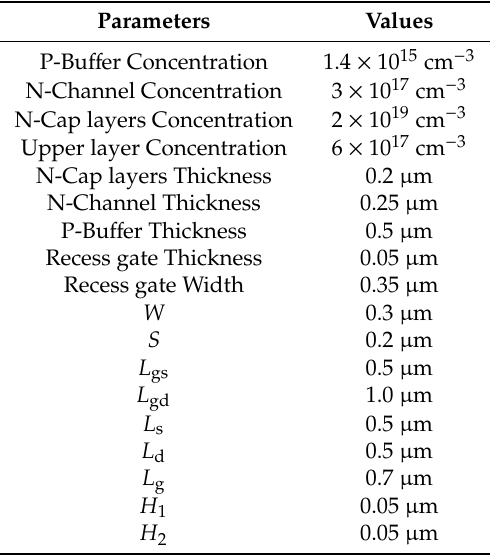
Table 1. Common parameters of the two structures